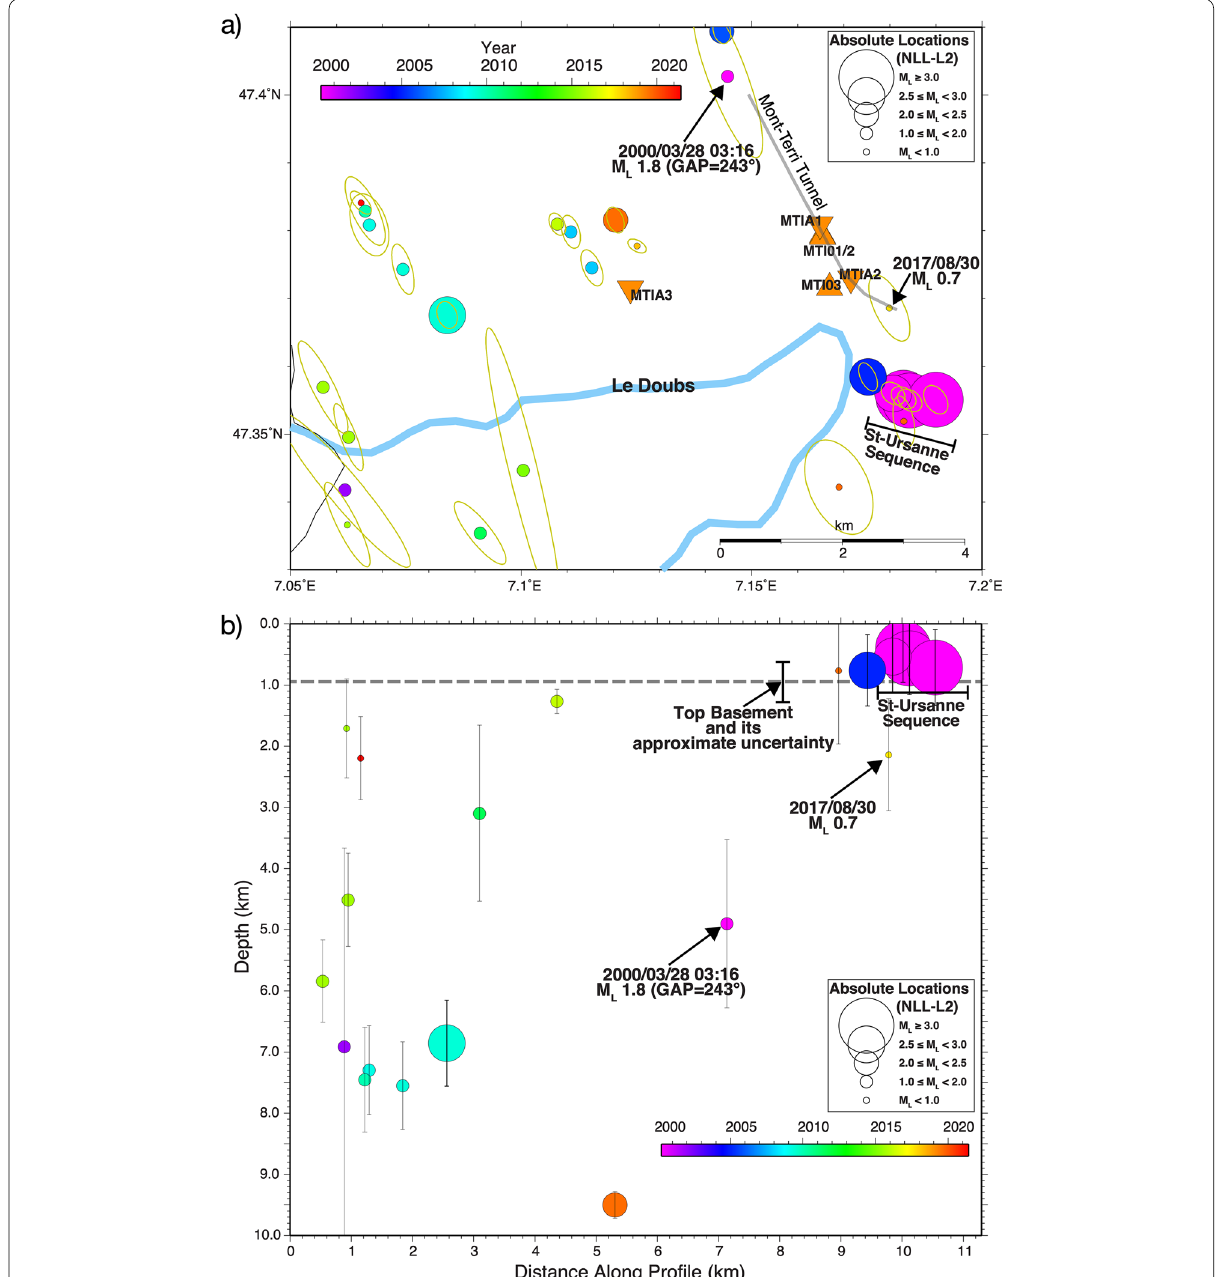
Fig. 4 Absolute relocations for shallow earthquakes listed in the SED catalogue from 2000 to 2021 (May 26th) in map view a and along an E-W profile b including only events of a with focal depths 10 km BSL. This includes also the event of August 2017, which was found through ≤ cross-correlation. In a we show NonLinLoc horizontal error ellipses. Vertical bars indicate the absolute uncertainty of focal depths. The gray, dashed line indicates the approximate top-basement at ~ 0.9 km depth BSL as inferred by integrating data from geological formations thickness of the area (Nussbaum et al., 2017) as well as the closest borehole logs in the NE (Weber et al., 1986) and in the SW of Saint-Ursanne (Rime et al.,